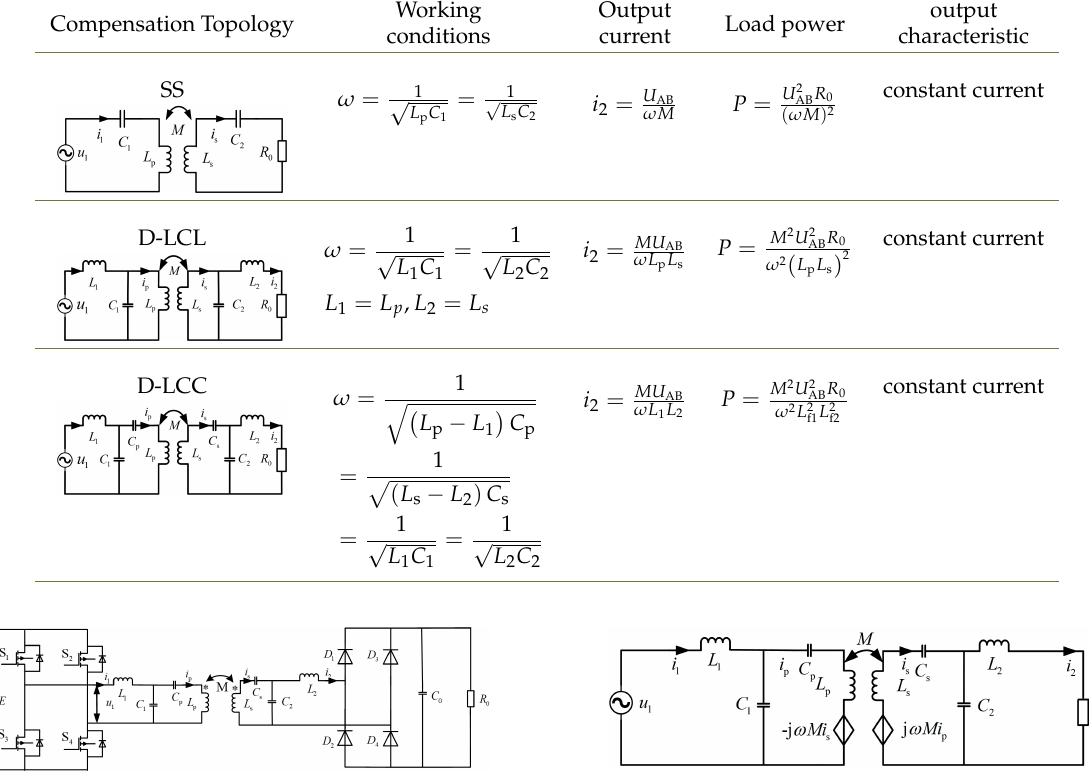
Fig. 3. Decoupling equivalent circuit diagram of